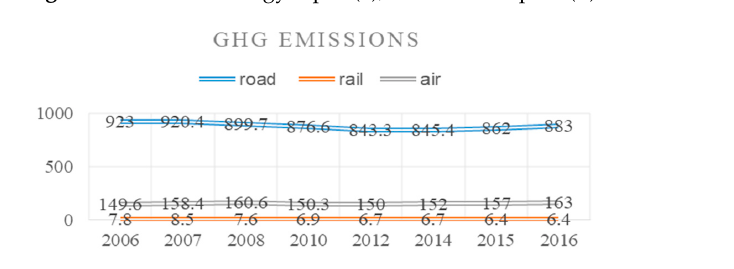
Figure 2. Trends of energy input ( a ), desirable outputs ( b ).